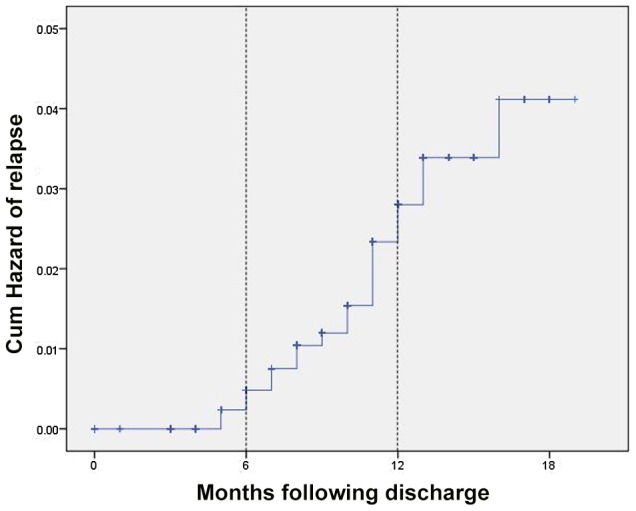
Censored Kaplan Meier curve showing the cumulative hazard of relapse over the time after discharge.